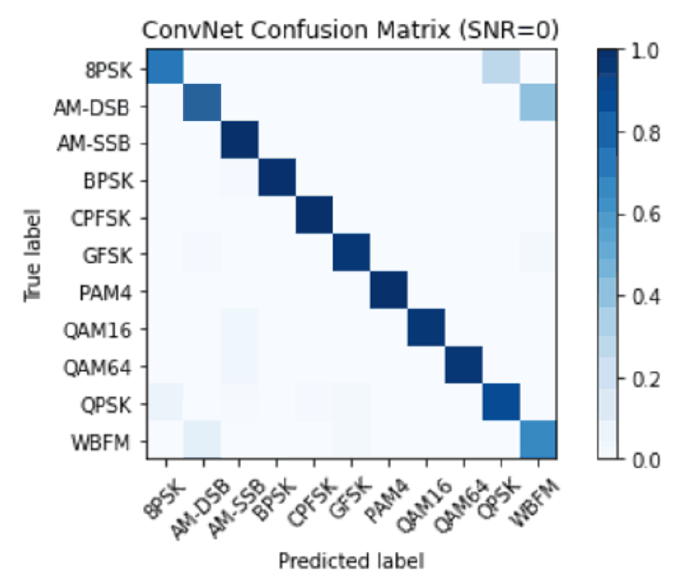
Figure 10. Confusion matrix on SNR = 0 dB (ResNeXt).